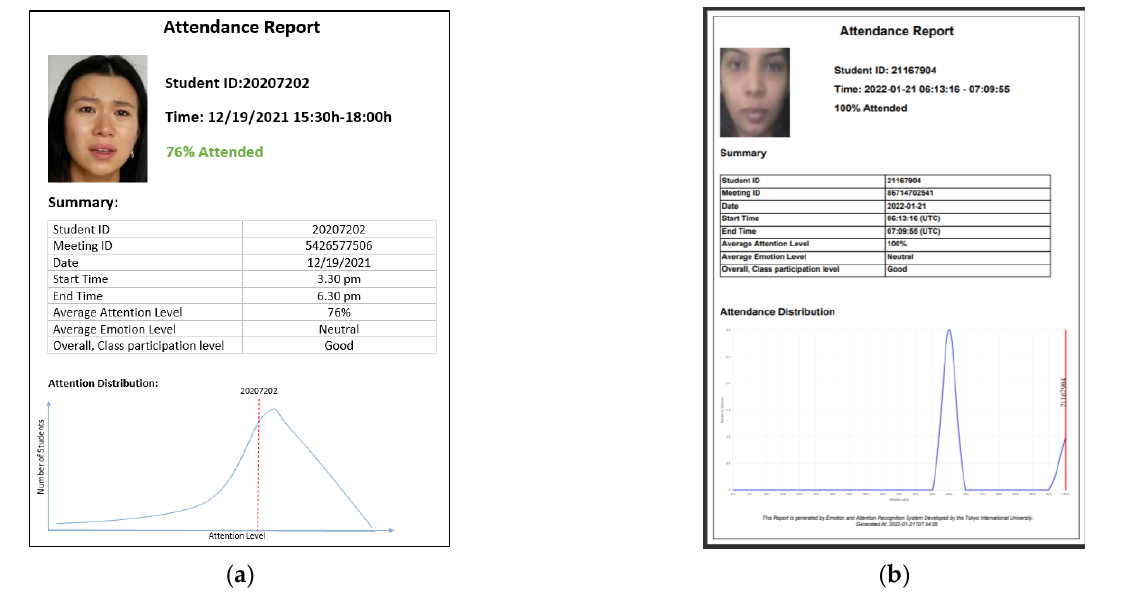
Figure 9. Attendance report generated by the system for a video conference: ( a ) theoretical report generated for a bigger audience; ( b ) actual report generated for four – participant audience. Table 4. Behavior matrix based on emotion class and attention